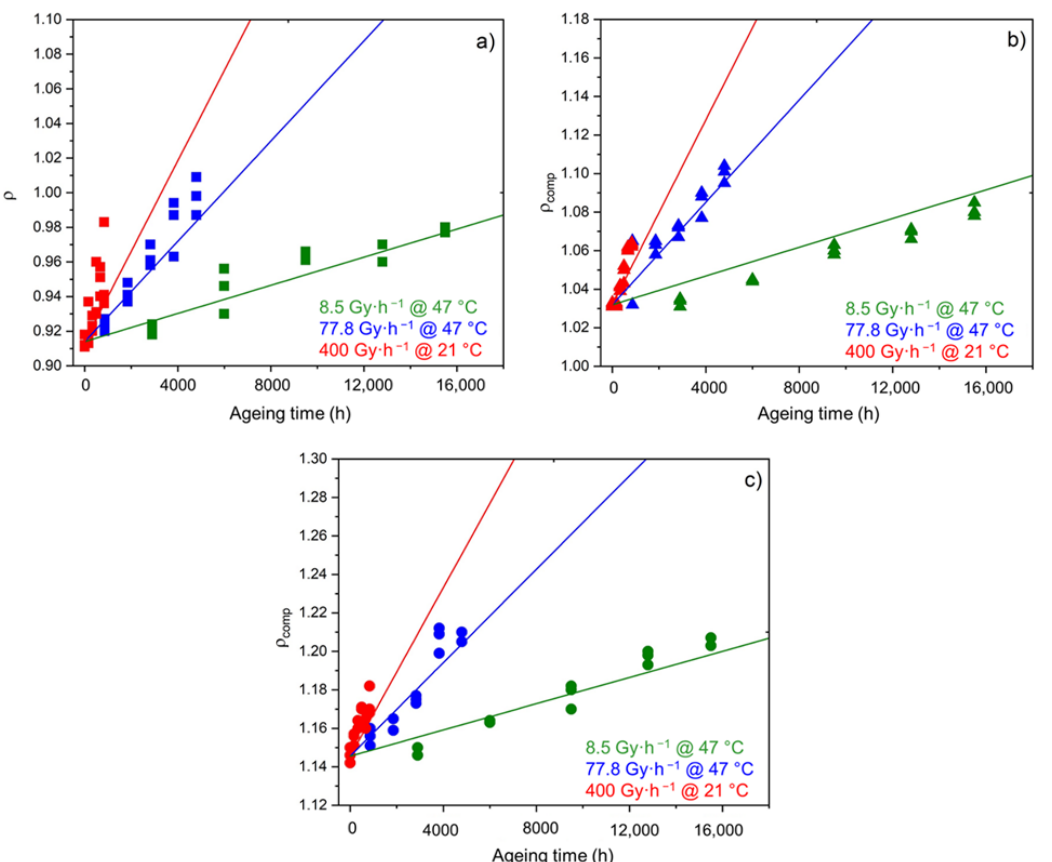
Figure 18. Kinetic modeling of the changes in the hydroperoxide concentration in the unfilled Si ‐ XLPE matrix ( a ) and the two composite materials with 25 phr ( b ) and 50 phr ( c ) of ATH, during their radio ‐ thermal exposure in air under 8.5 Gy ∙ h − 1 at 47 °C (green), under 77.8 Gy ∙ h − 1 at 47 °C (blue), and under 400 Gy ∙ h − 1 at 21 °C (red).